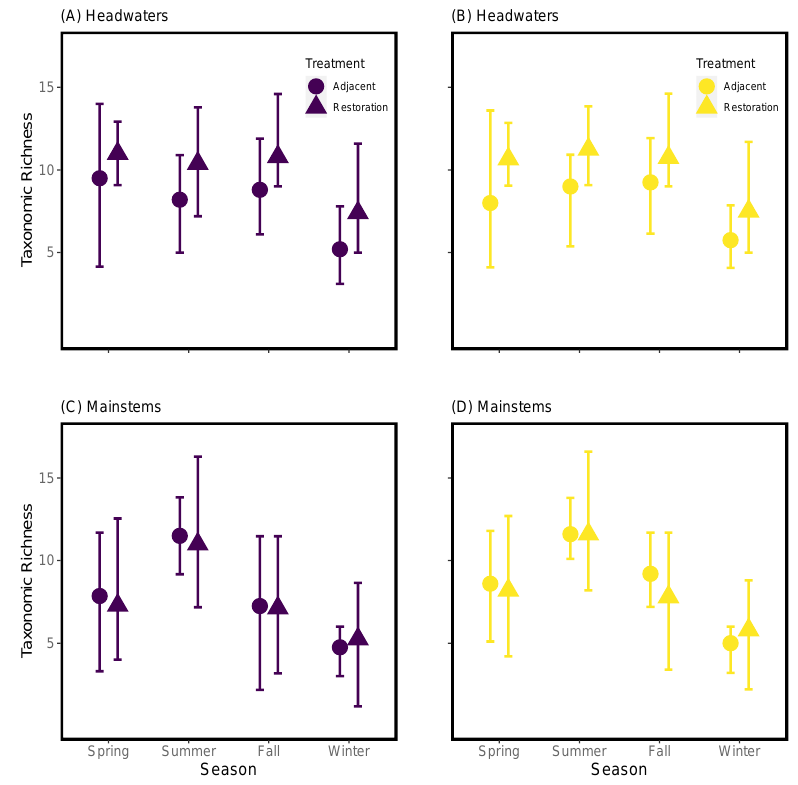
Figure 1 : Plots of taxonomic richness in headwaters (A and B) and mainstems (C and D). Taxonomic richness is reported for restored (triangles) and adjacent (circles) sites; values from the full sites are reported in purple (A and C), while those from the revised sites are reported in yellow (B and D). Points represent mean ± 95%